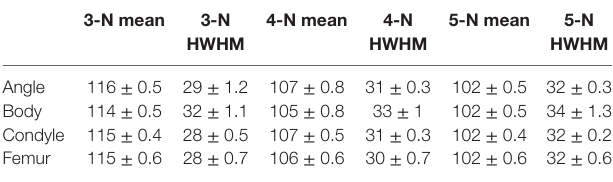
TaBle 2 | Mean values of ITA distributions per node type, averaged for the samples measured and half width at half maximum (HWHM) of ITA distributions per node type, averaged for the samples measured.